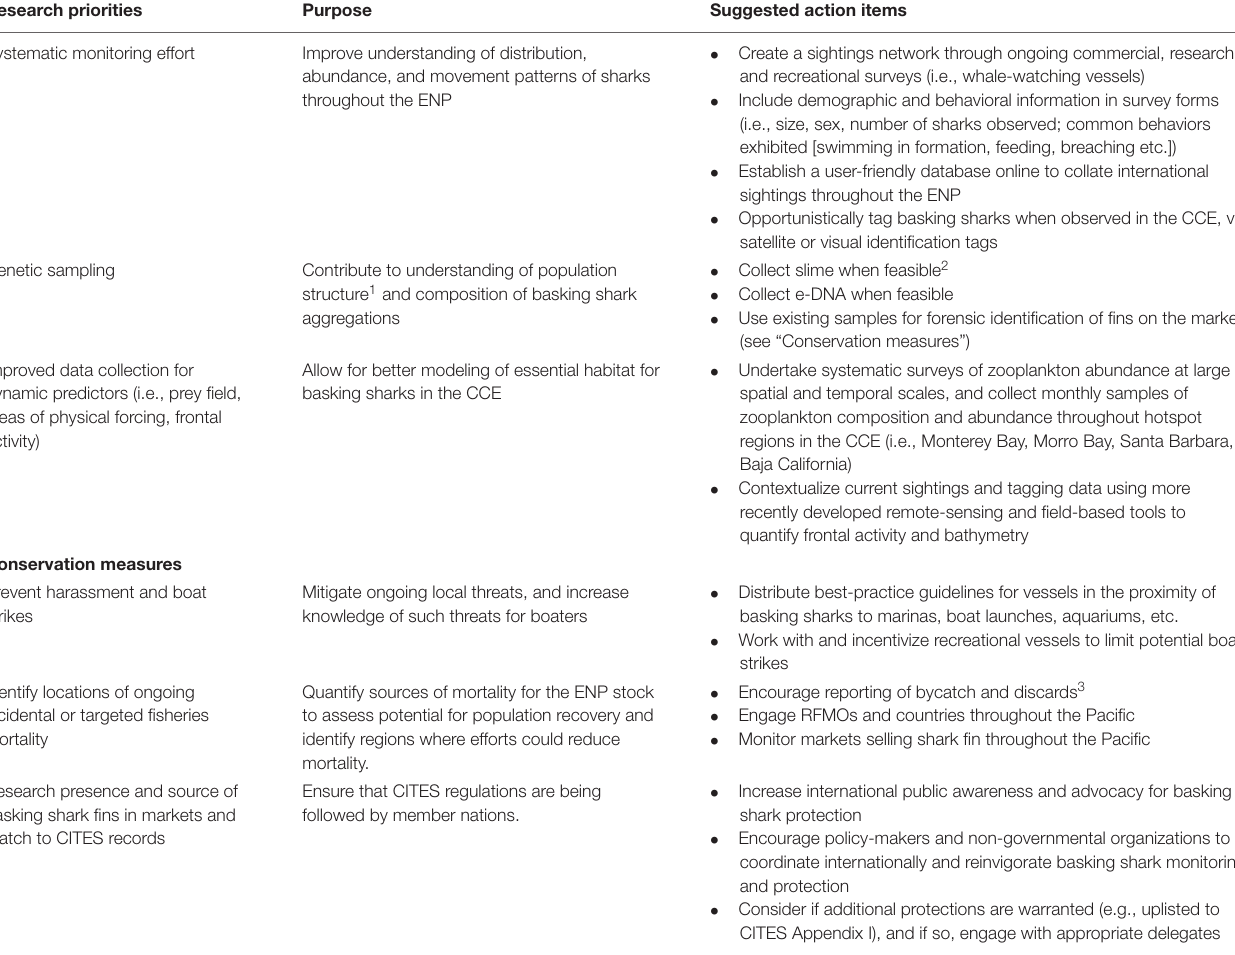
TABLE 2 | Recommendations for future research on and conservation of basking sharks in the CCE and broader Eastern North Pacific (ENP). Research